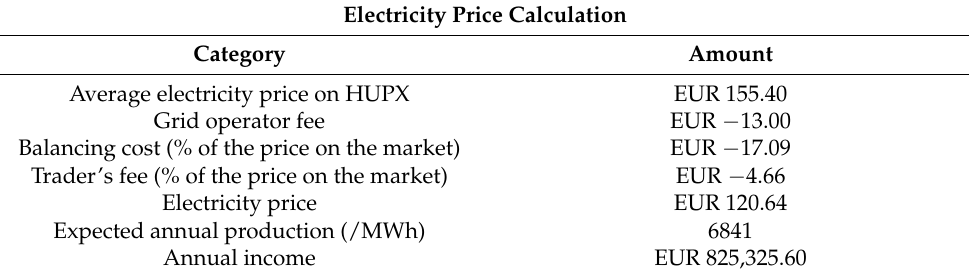
Table 7. On-site electricity price